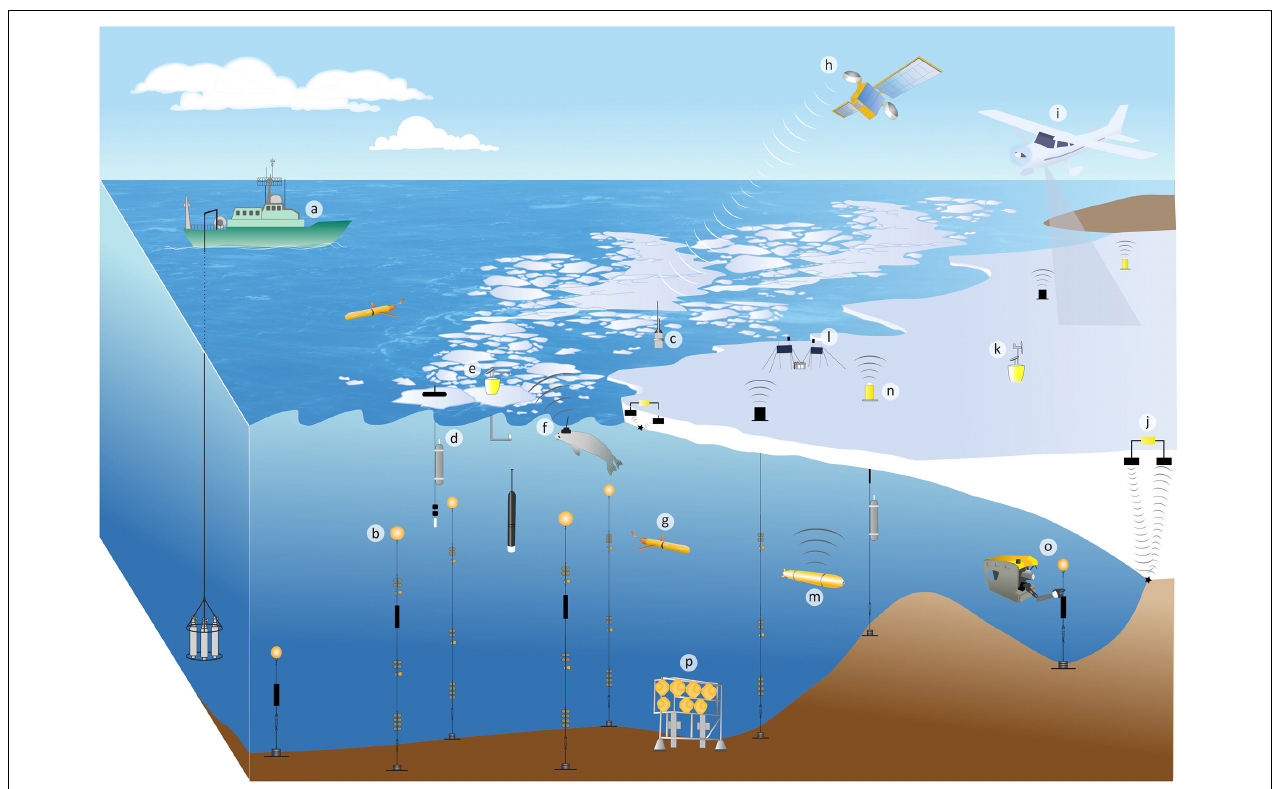
FIGURE 7 | A schematic of the integrated system of observational platforms required to determine the contribution of oceanic heat to ice-shelf melt for a generic ice-shelf configuration. An integrated system to observe the processes important for grounding line retreat and basal melt consists of three main components. Firstly, observing how ocean currents approach and exit the ice shelf cavity, achieved by a combination of ship-based observations, such as hydrographic sections (a) ; moored instrumentation (b) deployed in key locations across the front of the ice shelf (e.g., polynyas, dense overflows); ice-capable profiling floats (c) ; ice-tethered profilers (d) and ice-mass buoys (e) particularly in fast- or multi-year ice; seal tags (f) ; and gliders (g) for high-resolution transects on the shelf and slope. Secondly, determining changes in ice-shelf thickness, basal melt-rate, and grounding-line retreat, achieved by deployment of satellite (h) and airborne (i) remote sensing for ice shelf properties; ApRES radars (j) for direct basal-melt rates; automatic weather stations (k) , GPS, boreholes, and other sensors (l) for other properties, such as snow accumulation. Finally, observation of processes within the ice-shelf cavity itself requires AUVs (m) for observations of water properties, as well as swath mapping of sea floor and sub-ice shelf topography; sensors/moorings deployed through boreholes (n) for sub-ice shelf properties, circulation, and direct basal melt data, including mooring with ITPs and telemetry; moorings deployed by ROVs in ice shelf cavity (o) , which is not currently implemented but is a promising technological advance in the coming decade; and bottom landers (p) out the front of the ice shelf for a multitude of roles, such as communication gateways, imaging, water sampling, etc. This figure was modified from Meredith et al. (2013) and Rintoul et al. (2014) “seeing below the ice” 2014 strategy available at